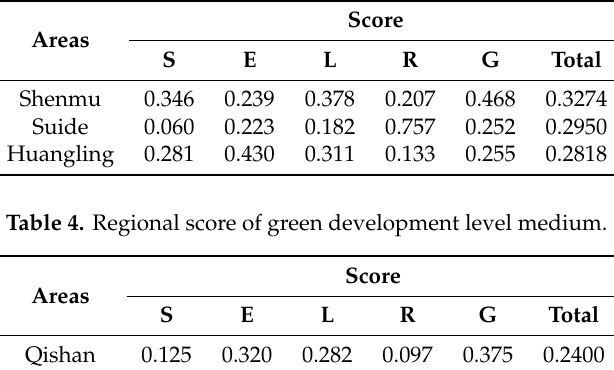
Table 3. Regional score of green development level strong.